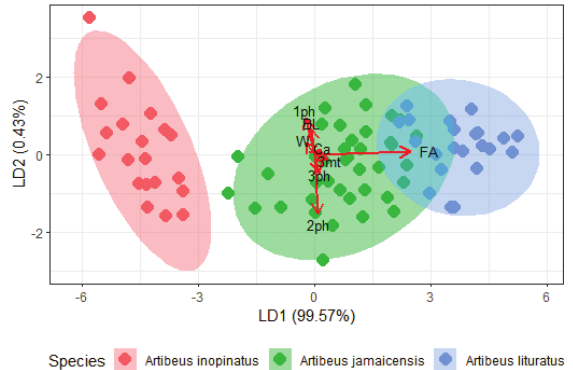
Figure 2. Linear Discriminant Analysis. LD1 just missed 0.43% to explain all the variance of the values of the morphometric measurements. Based on LD1 and LD2, the measurements with the highest value are the forearm length, third metacarpal length, the length of the second phalanx of digit III, and body length.